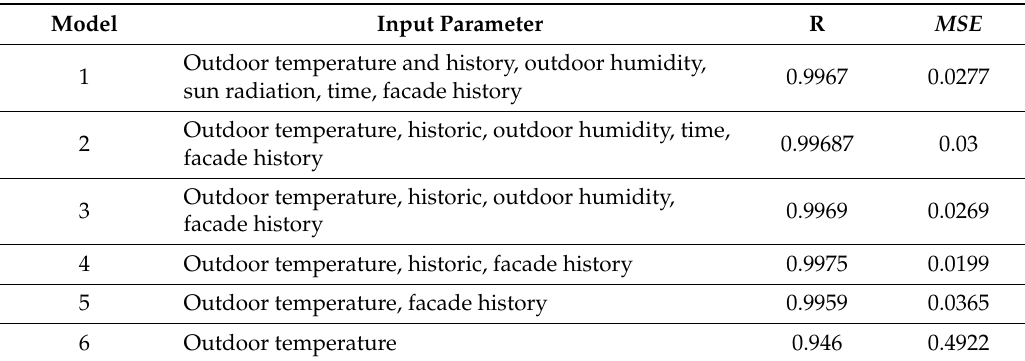
Figure 4. R results for different models: ( a ) Model 1; ( b ) Model 5; and ( c ) Model 6. Table 4. Degraded model